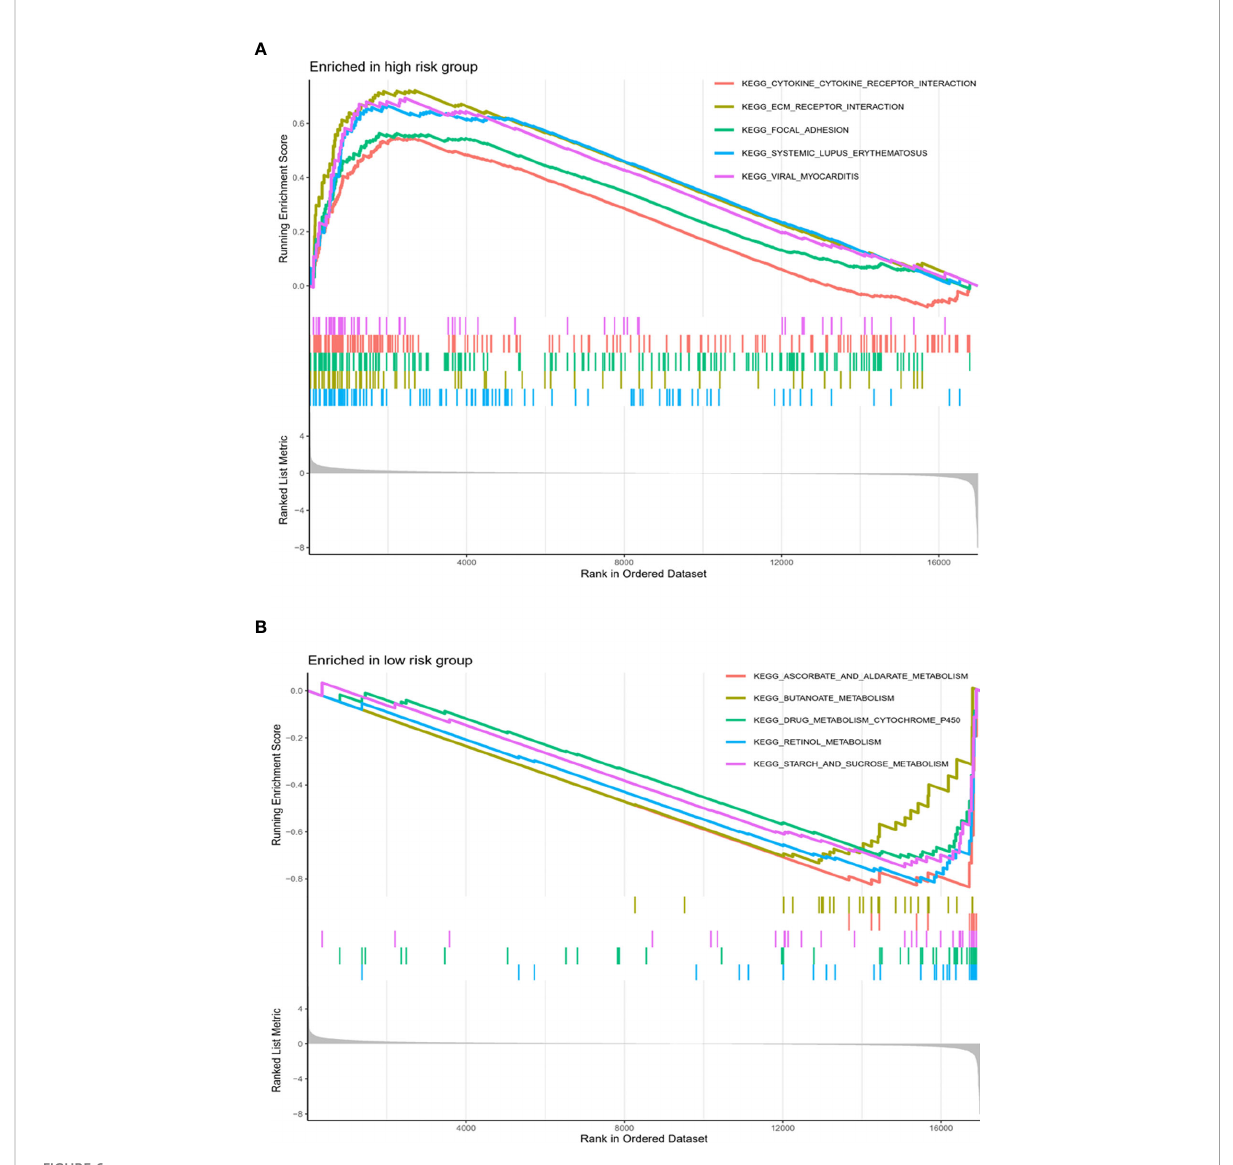
FIGURE 6 Pathways related to high-risk and low-risk phenotype. Pathways related to Cytokine-cytokine receptor interaction, ECM receptor interaction, focal adhesion were enriched in high-risk phenotype (A) . Pathways correlated with ascorbate and aldarate metabolism, butanoate metabolism, drug metabolism cytochrome p450, retinol metabolism and starch and sucrose metabolism were enriched in low-risk phenotype (B)